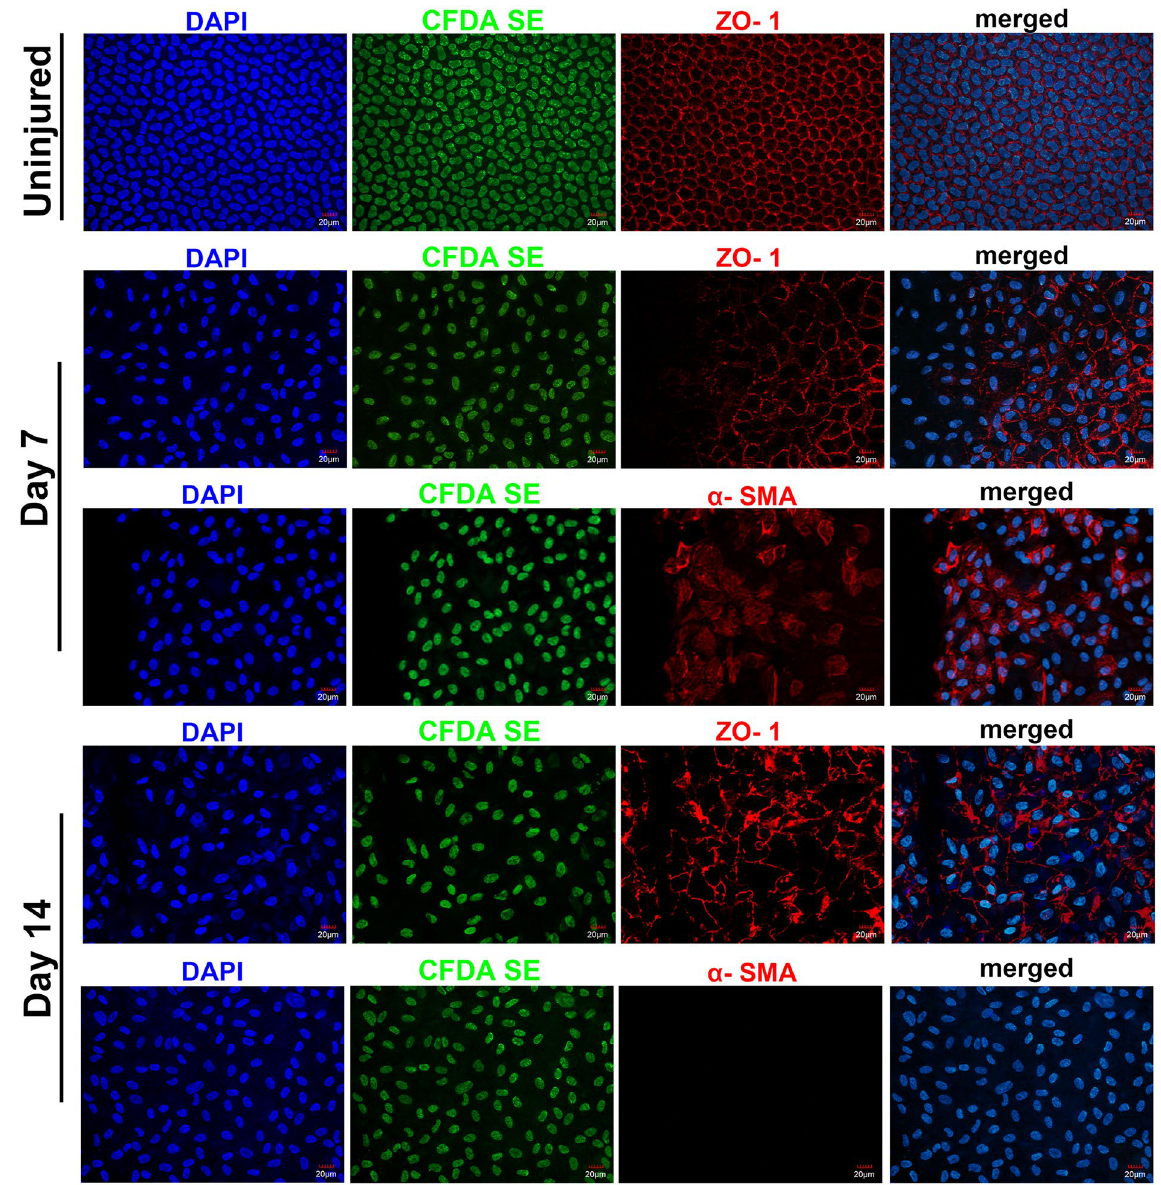
Figure 7. Whole-mount staining of ZO-1 and α -SMA on a CEC scraping cornea. ZO-1 expression decreased in the forefront of the migrating cells, while α -SMA was expressed in the migrating CECs on day 7. At day 14, ZO-1 was re-expressed on the cell border, although it was not as organized as that in the normal endothelium, while α -SMA became negative in all the endothelial cells. Bars represent 20 μ